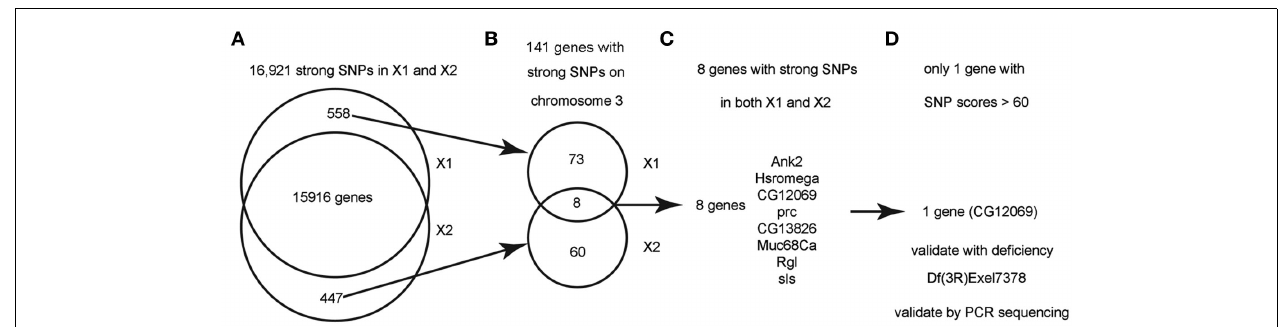
genes that are commonly affected by unique SNPs in both X1 and X2 (note that the eight genes have at least two SNPs at different bases). (C) List of the eight genes with SNPs in both X1 and X2. See Table 1 for more details. (D) Only one gene, CG12069/Pka -like, contained SNPs with scores > 60.These SNPs were validated by capillary sequencing of PCR-amplified DNA from the genetic interval of the male-sterile locus as defined by meiotic and deletion mapping data (see text).